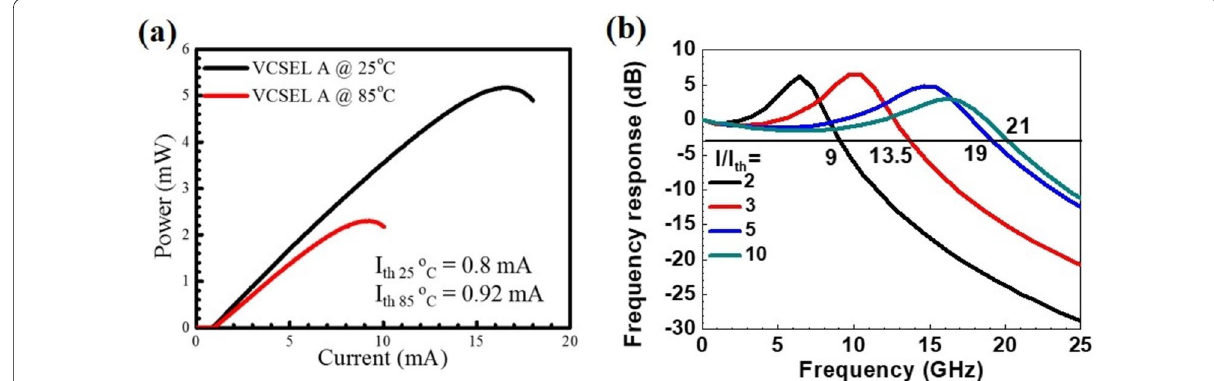
Fig. 9 Eye diagram of PAM4 signal transmitted by the 850 nm VCSEL at 56 Gb/s under a bias of I